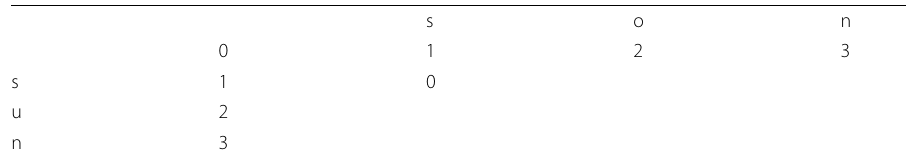
Table 3 Calculation for the first step